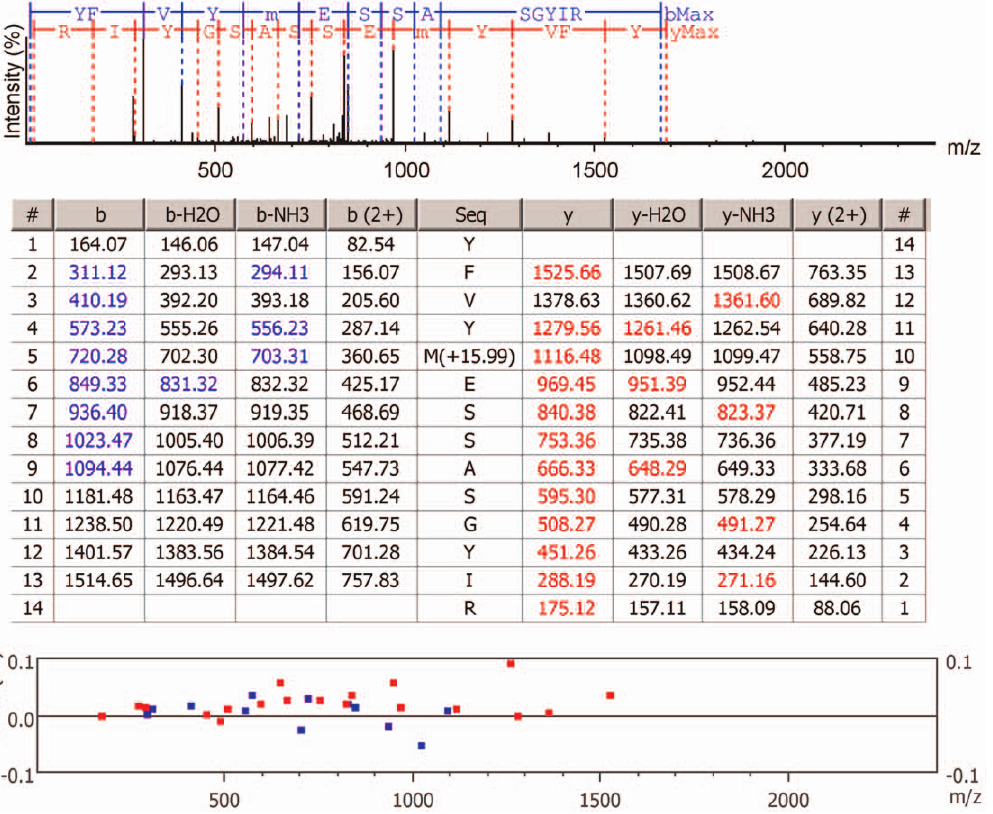
Figure 3. Representative example of a denovo sequence match to CaTX-A using a homology search. Representative spectra from a de novo match to the toxin protein CaTX-A. The top panel shows the spectrum annotated with the y and b-ion series, the middle panel shows fragment ions detected and the bottom panel the errors, in daltons, for each fragment ion.